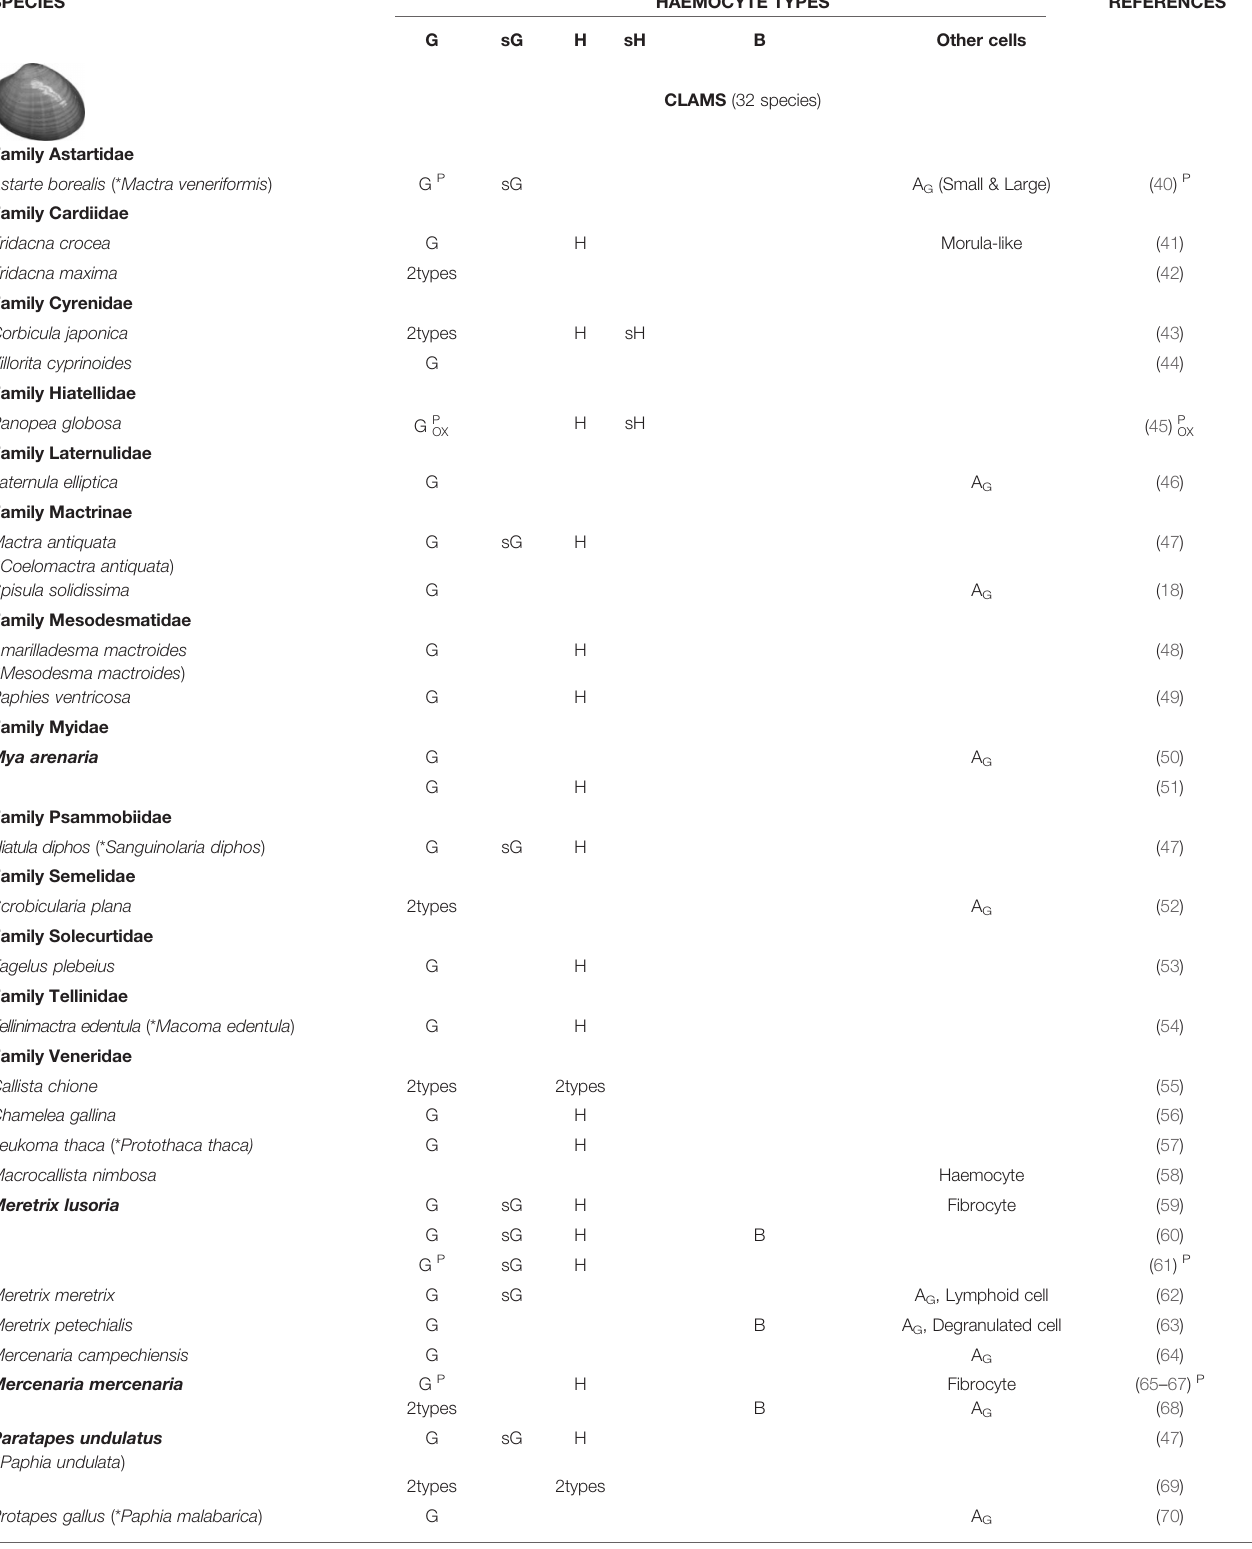
TABLE 1 | Haemocyte subpopulations in bivalve mollusc